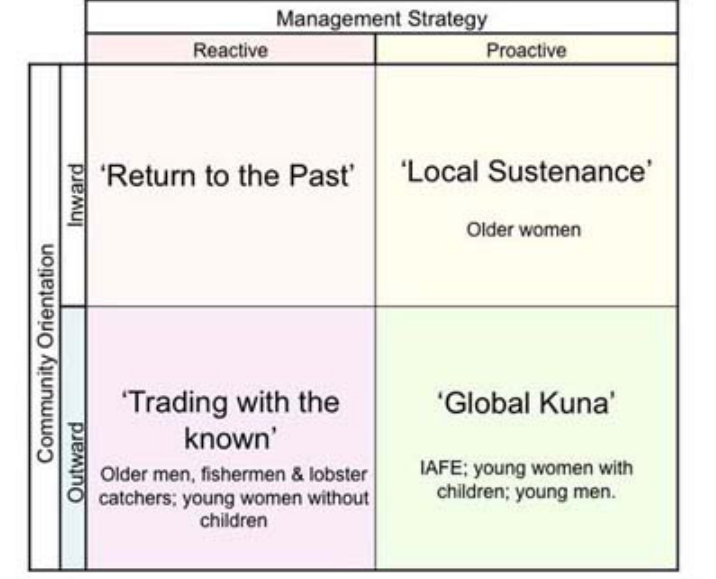
Fig. 4. Visions linked to scenarios arranged in the Vision Scenario Matrix structure. IAFE = individuals with an advanced formal